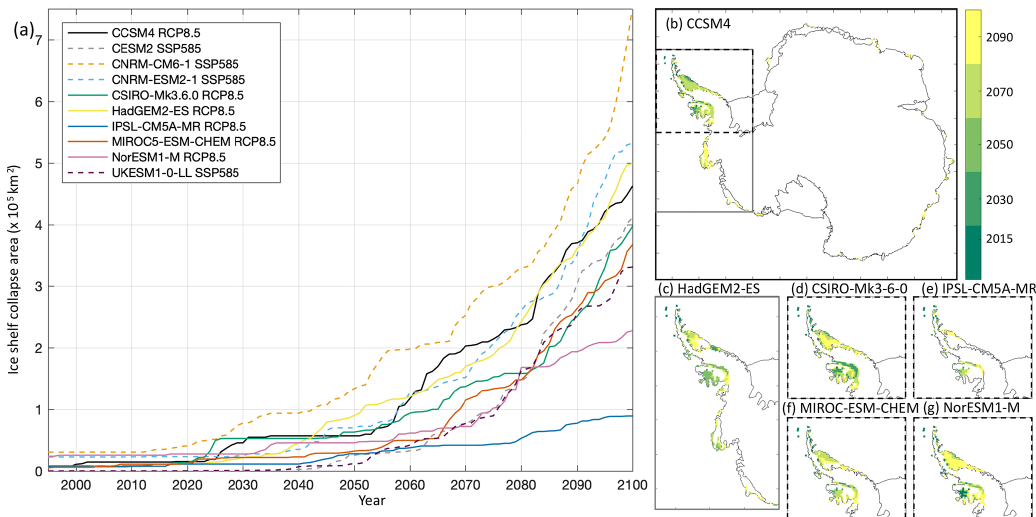
Figure 11. Time series of ice shelf collapse area under the RCP8.5 and SSP5-8.5 scenarios over the 21st century (a) and corresponding ice shelf collapse masks’ spatial evolution (b–g) . The CMIP5 models are CCSM4 (blue, b ), HadGEM2-ES (green, c ), CSIRO-Mk3.6.0 (green, d ), IPSL-CM5A-MR (cyan, e ), MIROC-ESM-CHEM (red, f ), and NorESM1-M (pink, g ). The masks’ spatial extent shown originates from the 4km datasets and corresponds to the years 2015, 2030, 2050, 2070, and